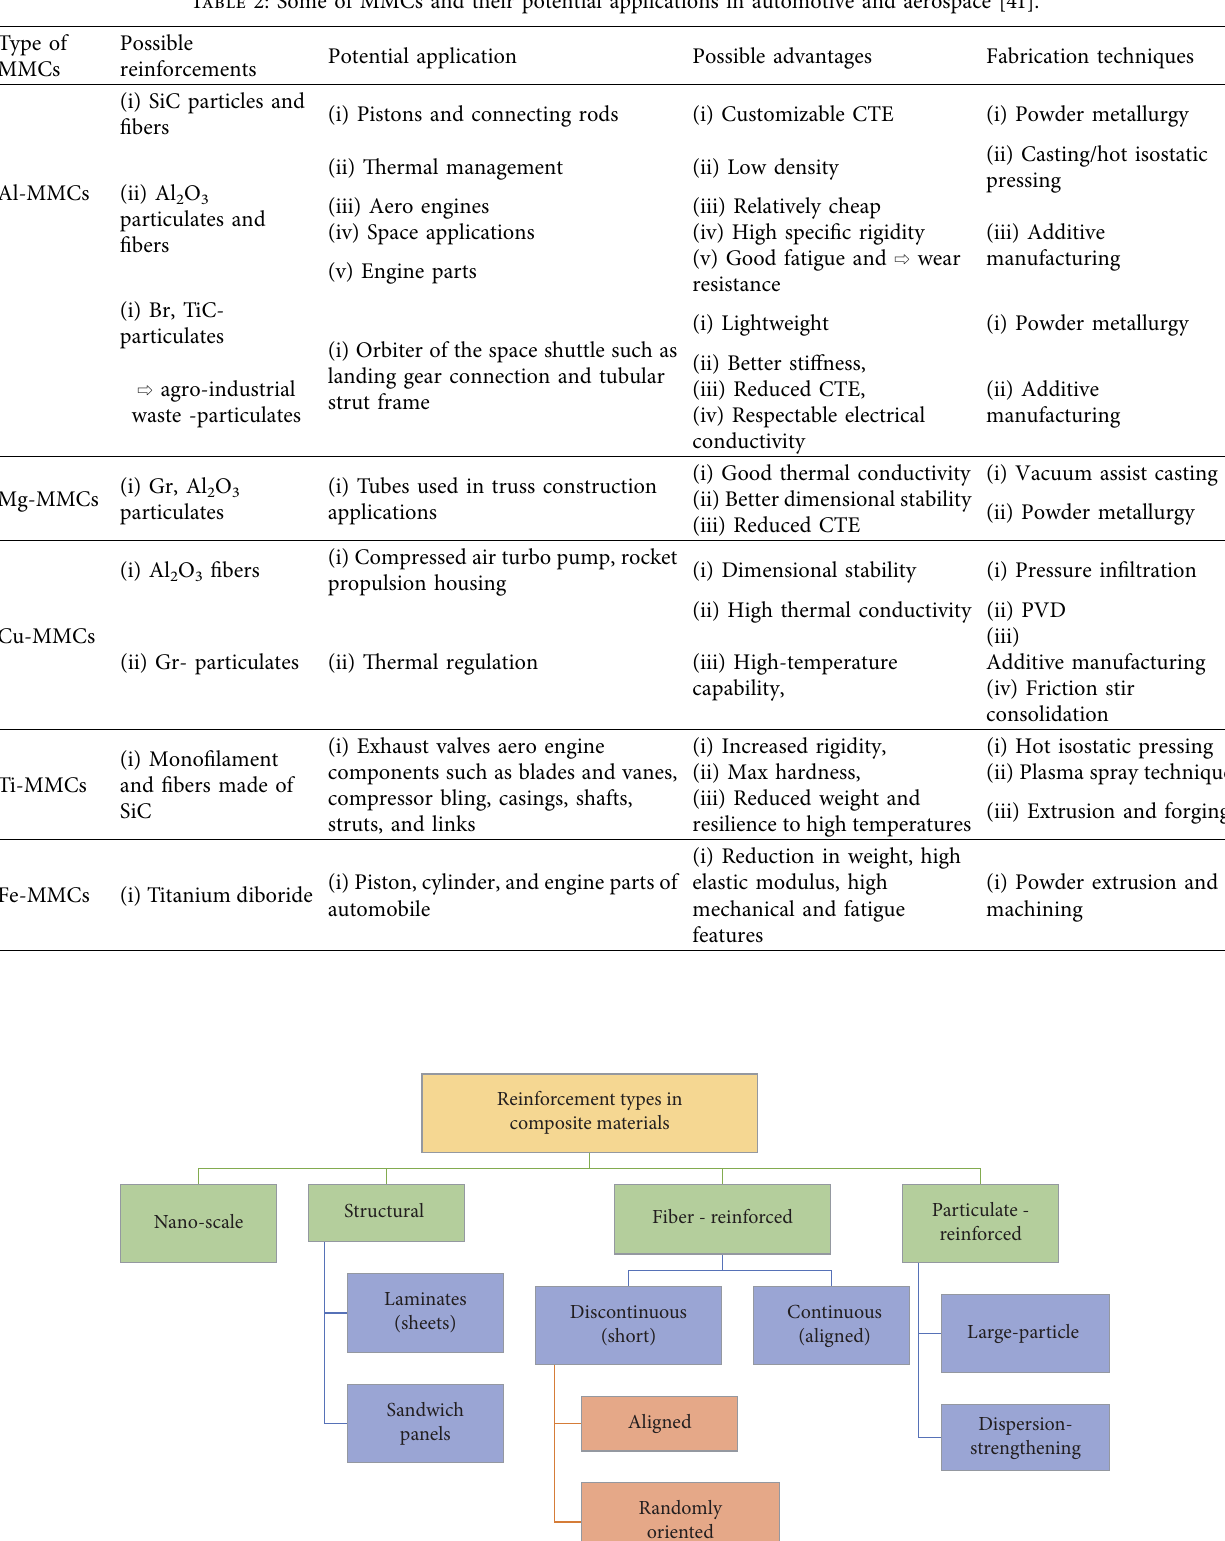
Table 2: Some of MMCs and their potential applications in automotive and aerospace [41].